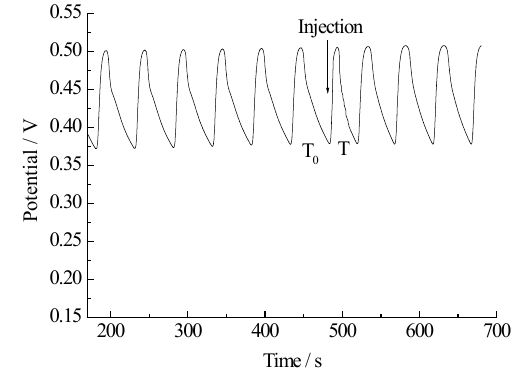
Figure 1. The perturbation of Eu 3+ to the regular B-Z oscillating chemical system. Experimental conditions: [acetone] = 1.42×10 –2 mol L -1 ,